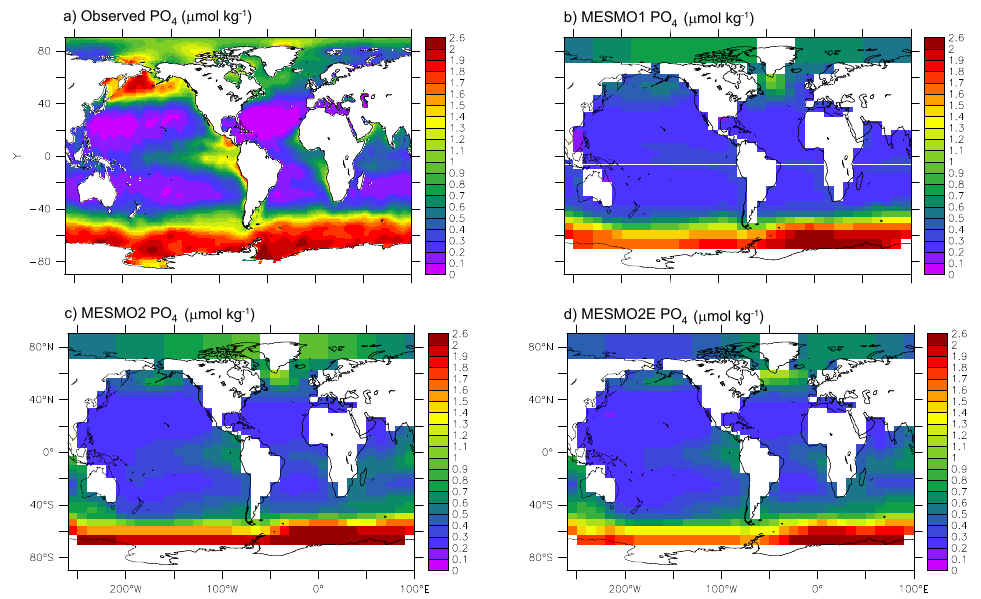
Fig. 8. Observed and model-simulated annual mean PO 4 concentration in the top 45m. Observations are based on the World Ocean Atlas 2009 (Garcia, 2010).